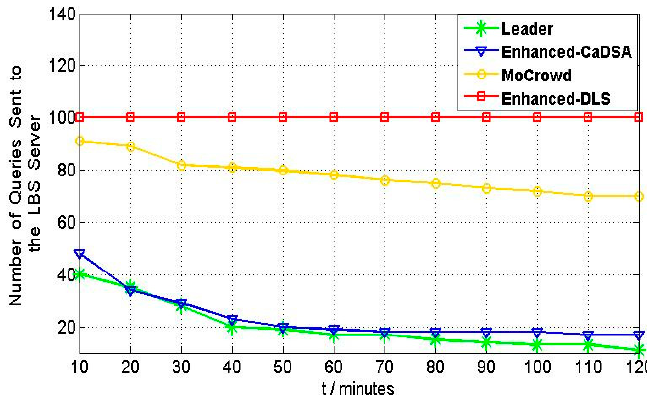
Figure 11. Communication cost VS. Time progress.